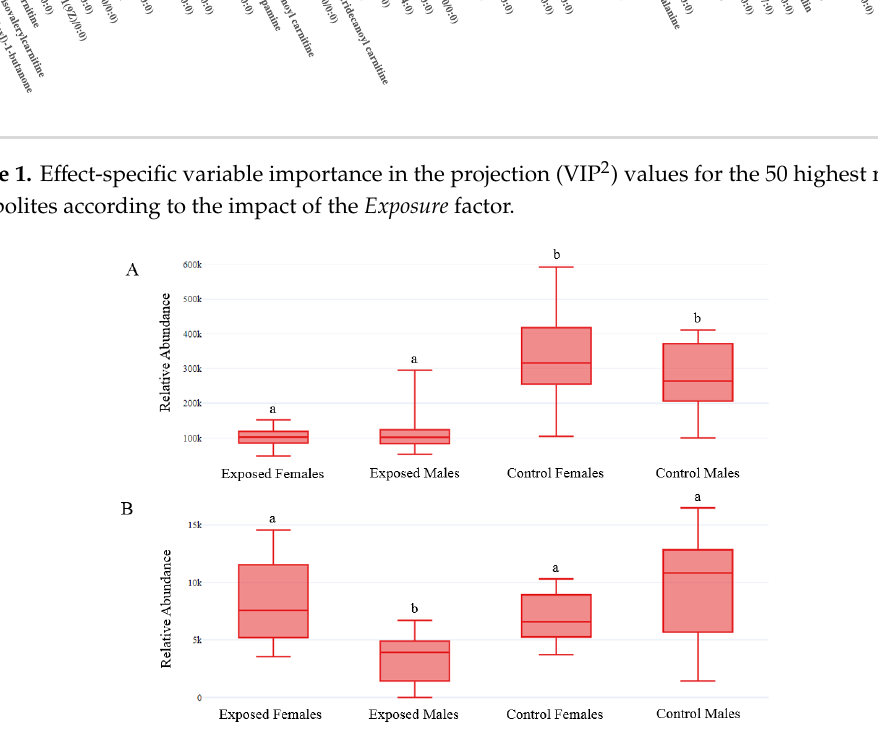
Figure 2. Boxplots illustrating an exposure-specific modulation of LPC (14:0/0:0) in both male and female mussels ( A ) and a gender-specific modulation of 1-pentadecanoyl-glycero-3-phosphate only in males ( B ). Different letters (a and b) mean significant difference ( q -value < 0.05) between relative abundances.